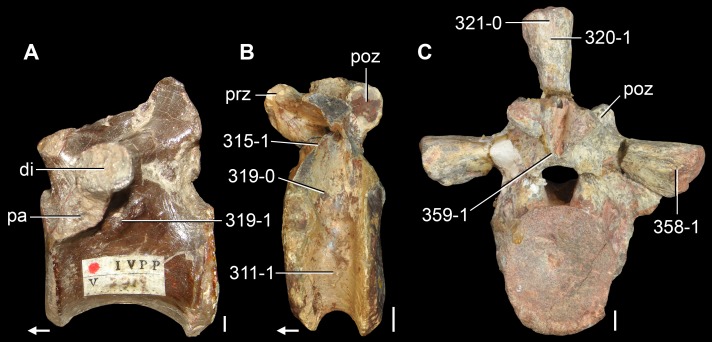
Cervico-dorsal and dorsal vertebrae of Early and Middle Triassic non-eucrocopodan archosauriforms in (A, B) left lateral and (C) posterior views.(A) Middle dorsal vertebra of “Chasmatosaurus” yuani (IVPP V2719); (B) anterior dorsal vertebra of Erythrosuchus africanus (NHMUK PV R3592); and (C) anterior dorsal vertebra of Sarmatosuchus otschevi (PIN 2865/68-20). Numbers indicate character-states scored in the data matrix and the arrows indicate anterior direction. Scale bars equal 2 mm in (A), 2 cm in (B), and 5 mm in (C).